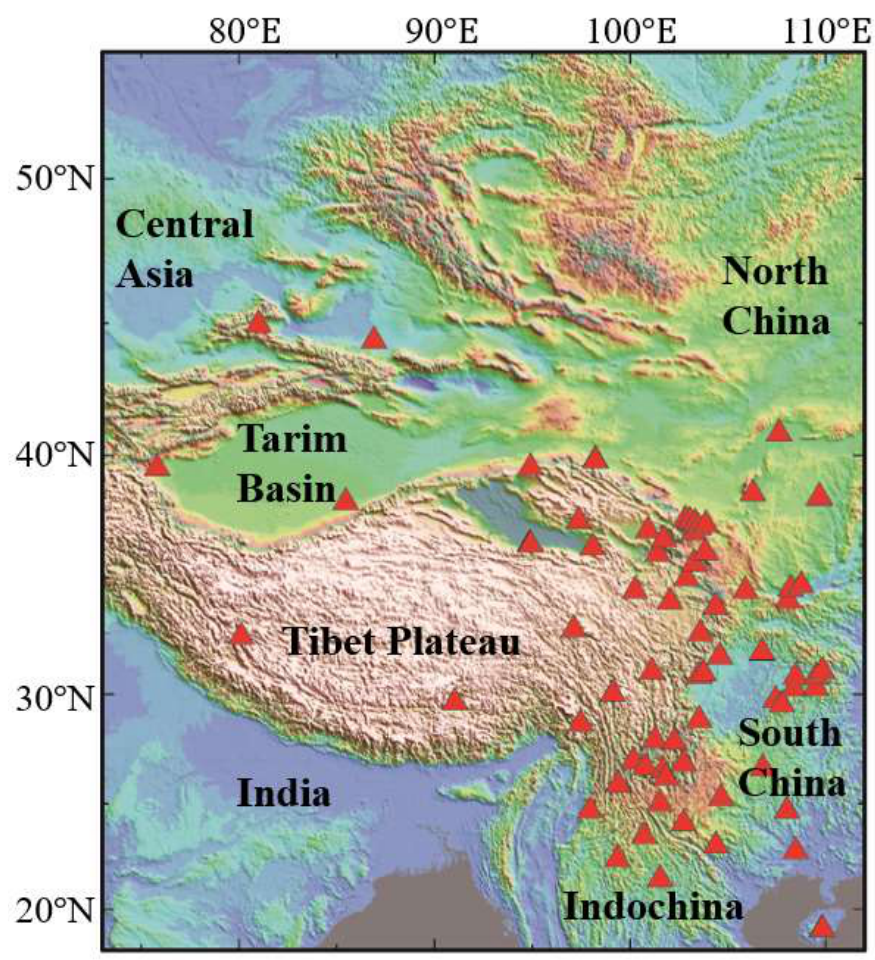
Figure 1. The distribution of 1-s sampling fluxgate magnetometer observation stations in western China in 2019. The red triangles indicate the geomagnetic observation stations.